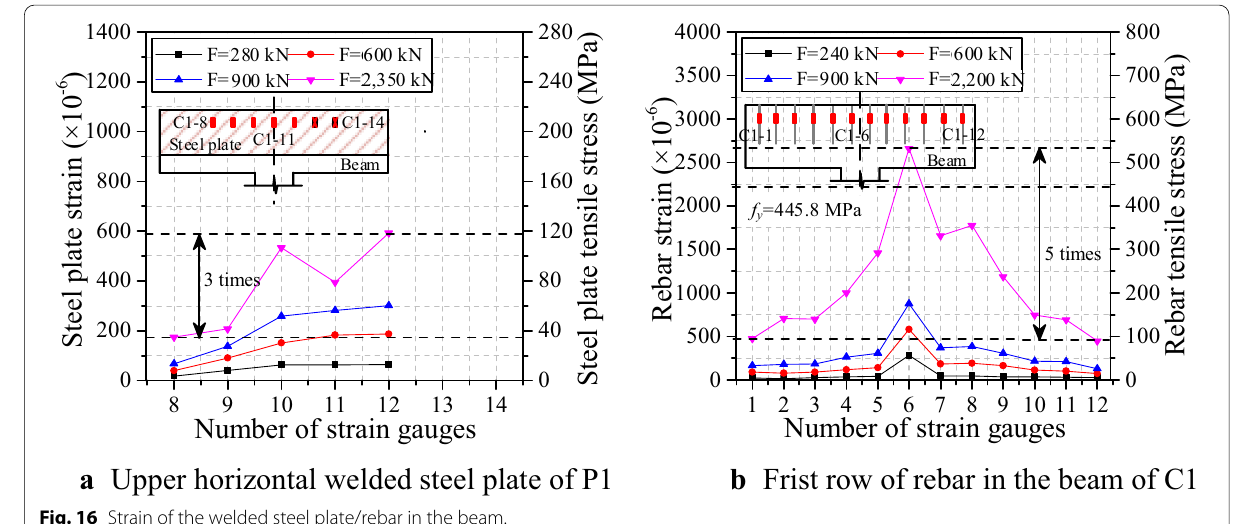
Fig. 16 Strain of the welded steel plate/rebar in the beam.